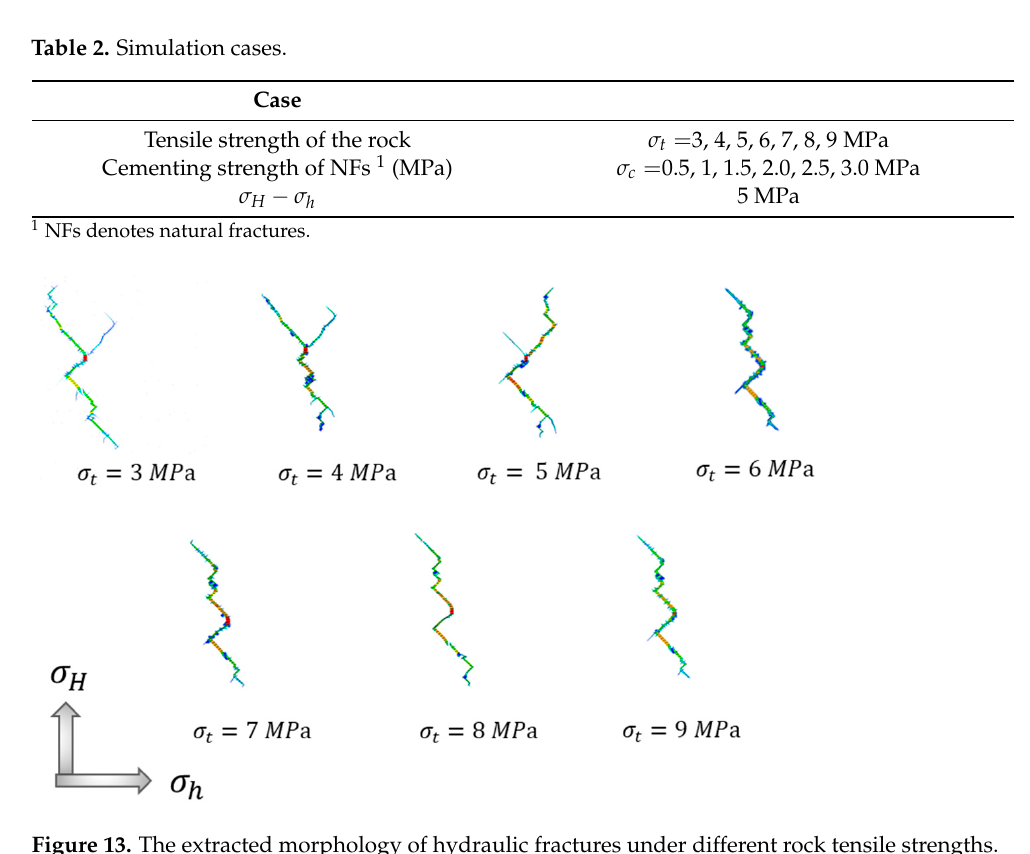
Figure 13. The extracted morphology of hydraulic fractures under different rock tensile strengths.